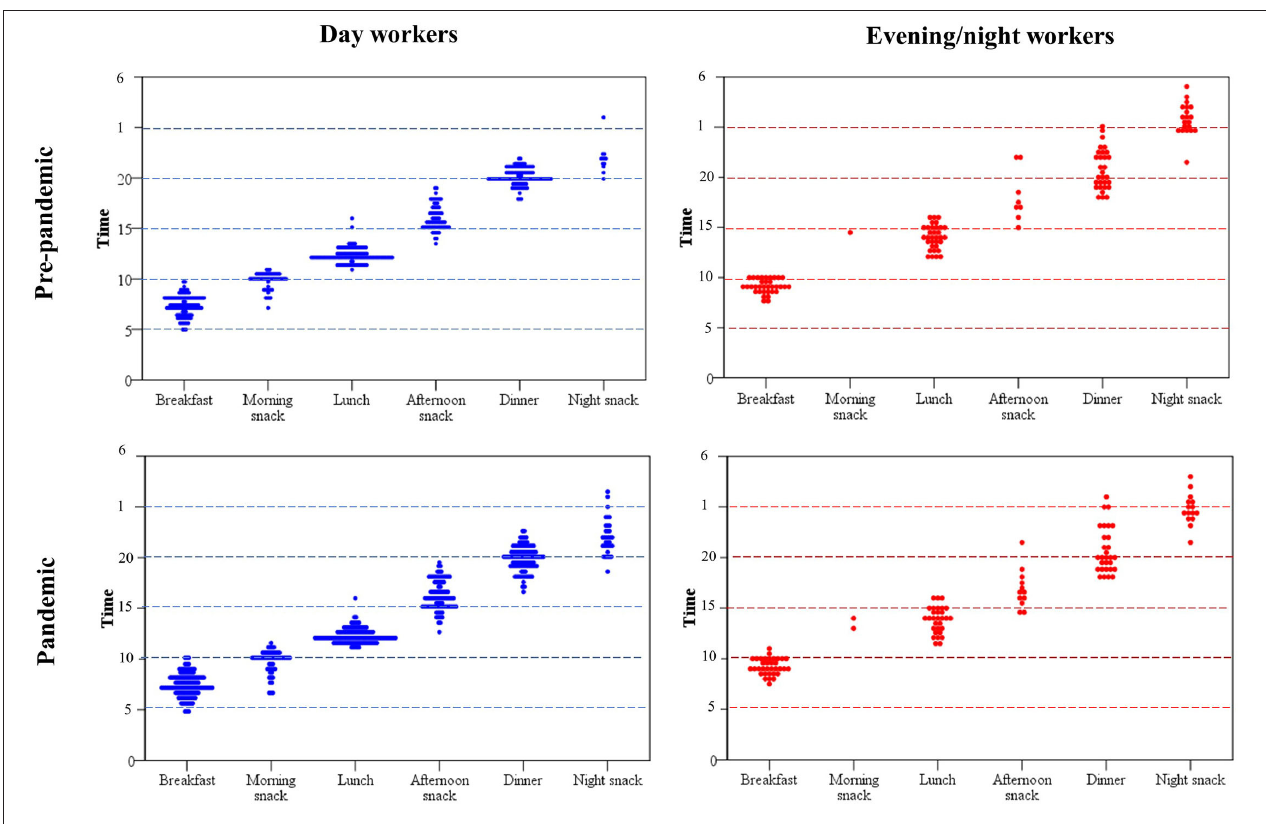
FIGURE 2 | Dispersion of meal timing in the pre-pandemic period and during the pandemic per work shift.